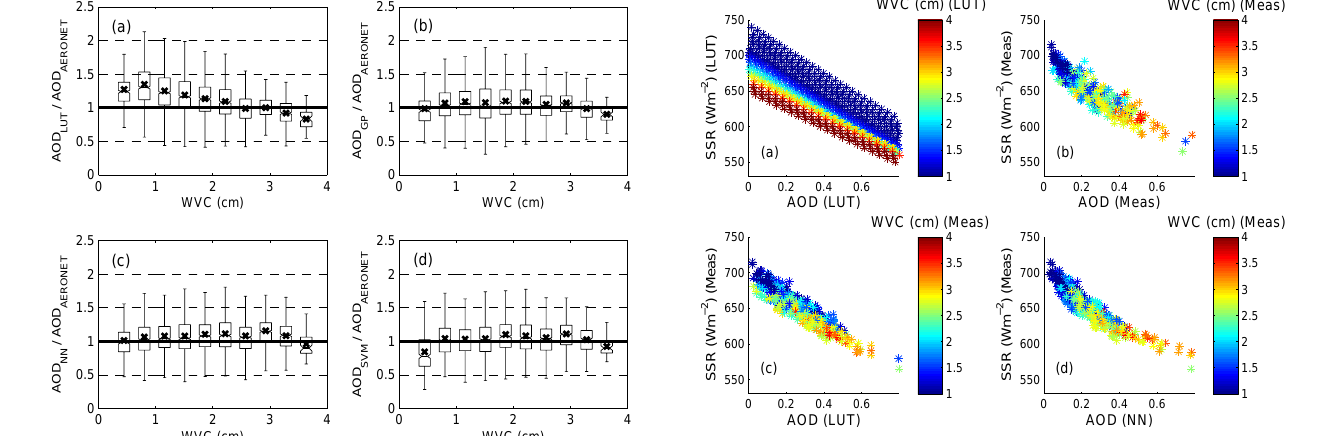
Figure 4. The same as Fig. 3, but the ratio of predicted to measured AOD is given as a function of the water vapour content (WVC).